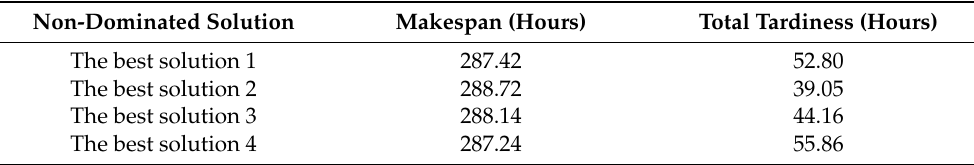
Figure 9. Pareto scatter diagram of the final solution. Table 5. Target values of non-dominated